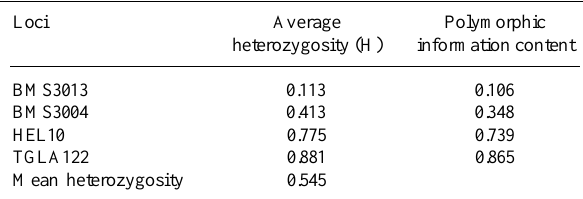
Table III - Genetic diversity considering Brangus-Ibagé cattle and other taurine populations.